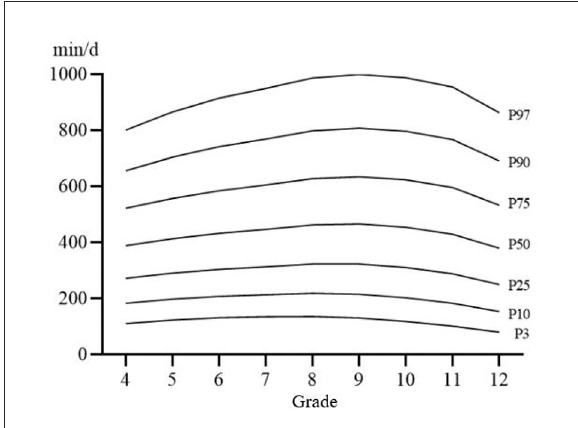
FIGURE3 Distribution curve of percentile of sedentary time on weekends.